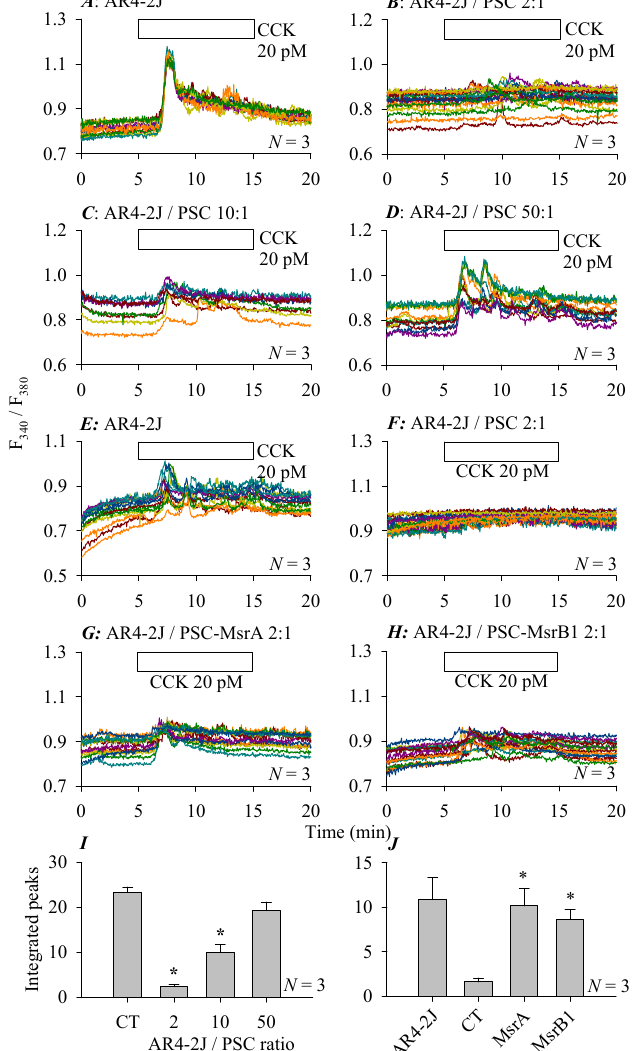
Figure 6. Co-culture inhibition of CCK-induced calcium oscillations in AR4-2J: Modulation by AR4-2J/PSC ratio or stellate cell Msr over-expression. AR4-2J cells cultured alone ( A , E ) or AR4-2J cells co-cultured at AR4-2J:PSC ratios of 2:1 ( B , F – H ), 10:1 ( C ), 50:1 ( D ) at 48 h ( A – D ) or 24 h ( E – H ) of AR4-2J seeding or co-culture, cells were loaded with Fura-2 AM. Pancreatic stellate cells used for co-culture with AR4-2J in ( F – H ) were transfected with either blank vectors ( F ) or with vectors containing gene for MsrA ( G ) or MsrB1 ( H ). Fura-2-loaded cells were perfused, CCK 20 pM (5–15 min) was added as indicated by the horizontal bars. Color-coded calcium tracings ( A – H ) in each panel are from individual AR4-2J cells from representative experiments with AR4-2J cultured alone or with AR4-2J/PSC co-culture. Experiments in ( A – D ) and ( E – H ) were done in time-matched parallel respectively. Quantification of CCK-induced calcium oscillations (integrated calcium peaks above baselines, min 5–15) from ( A – D ) or from ( E – H ) were plotted in ( I ) or ( J ) respectively. Asterisks (*) indicate statistical significance between AR4-2J alone ( A , CT, control) and AR4-2J/PSC co-culture at different ratios (2, 10, 50, B – D ) in ( I ) or between AR4-2J cells co-cultured with pancreatic stellate cells transfected with blank vectors ( F , CT, control) and AR4-2J cells co-cultured with pancreatic stellate cells over-expressing MsrA ( G ) or MsrB1 ( H ) in ( J ), at p < 0.05, N =